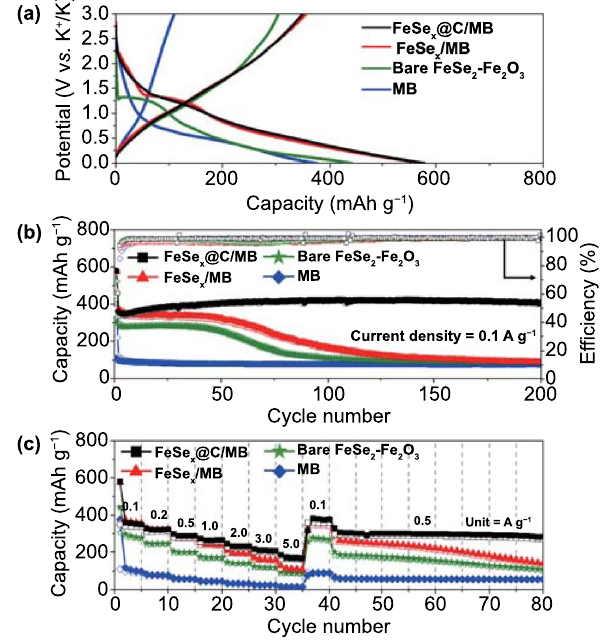
Fig. 8 Electrochemical properties of FeSe x @C/MB, FeSe x /MB, bare FeSe 2 –Fe 2 O 3 , and MB: a initial charge–discharge curves, b cycle per‑ formances at a current density 0.1 A g −1 , and c rate performances at various current